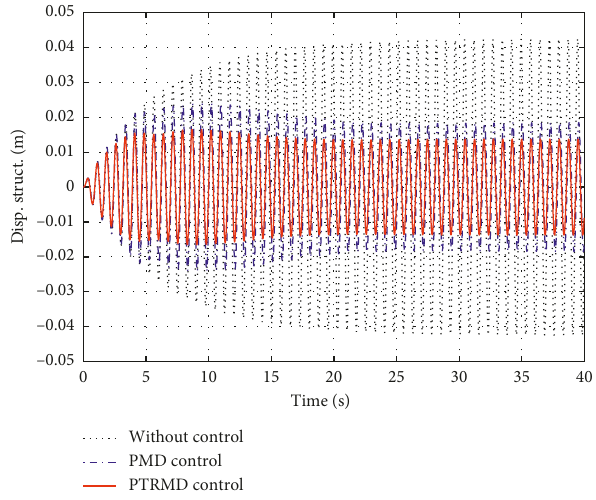
Figure 6: Response of PMD- and PTRMD-controlled structure subject to harmonic